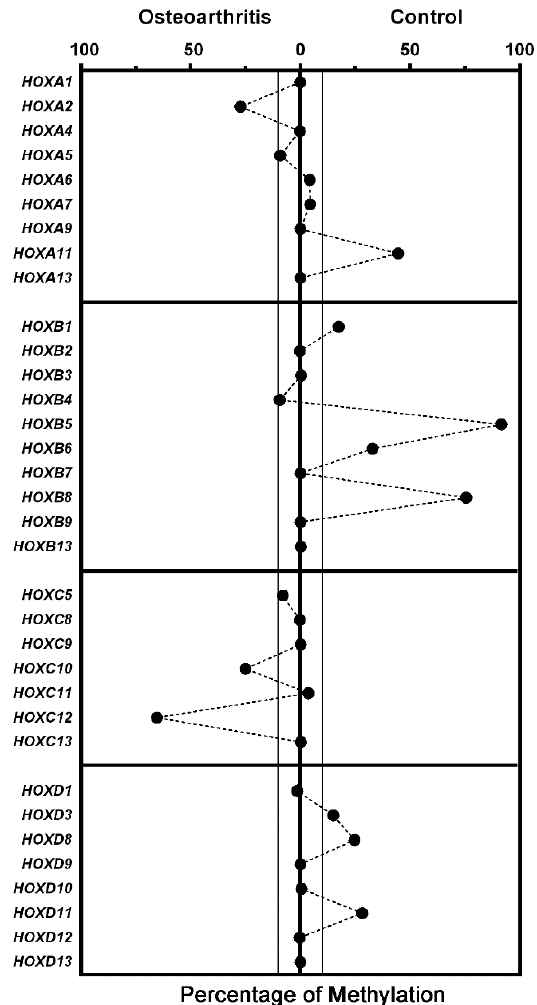
Figure 3. Methylation status of HOX gene promoters. The graph shows the difference in the percentage of methylation (hypermethylation) between OA-MSCs and Control-MSCs, calculated for each of the promoters of the indicated genes, grouped by clusters. The boundaries indicate methylation differences greater than 10%. Dashed lines between values have been drawn for ease of reading and data visualization.